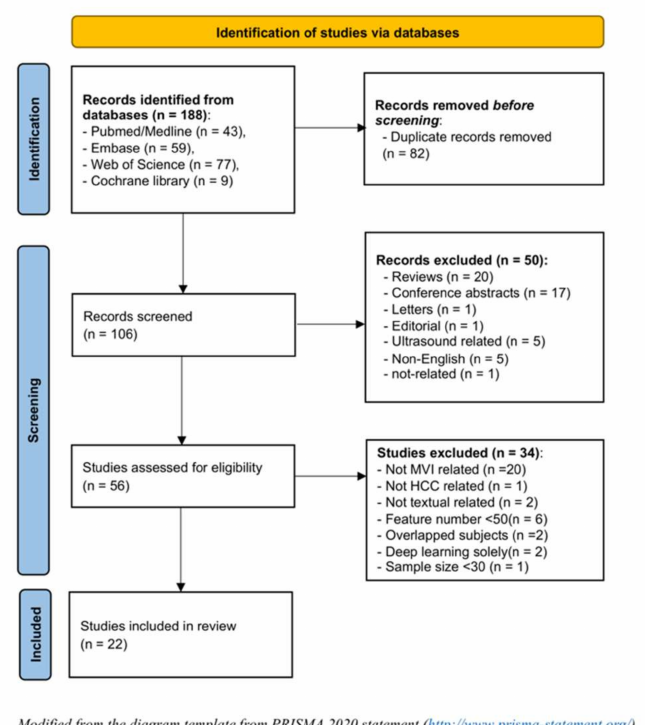
Figure 2. Flow chart of the study